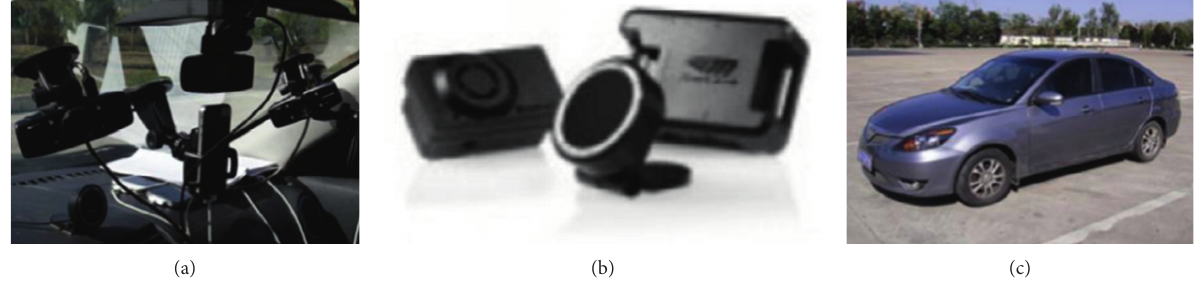
Figure 4: (a) Driving recorder, (b) mobileye, (c) experimental vehicle.